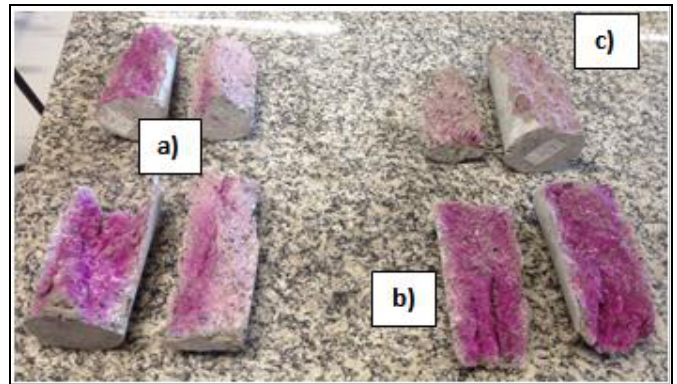
Figura 10: Observação dos CP’s aos 7 dias após aplicação do indicador químico de fenolftaleína. a)Traço com 0,0% de fibra; b)Traço com 0,5% de fibra; c)Traço com 1,0% de fibra.